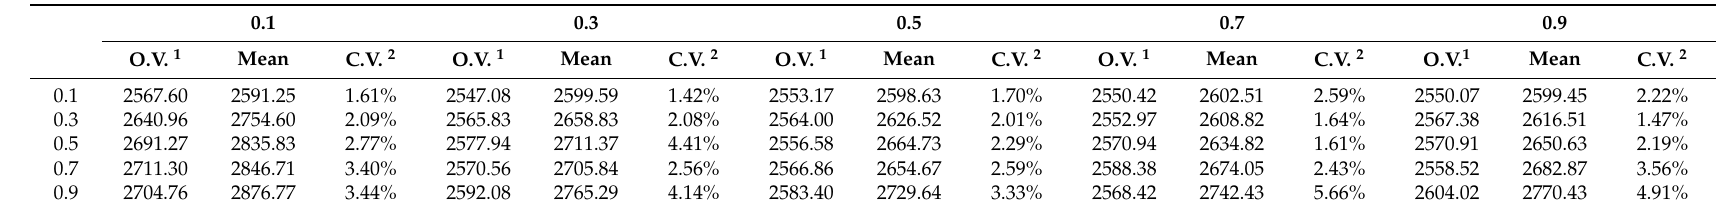
Table 7. Selection of two variation probabilities in 2-Random Exchange (2RE)